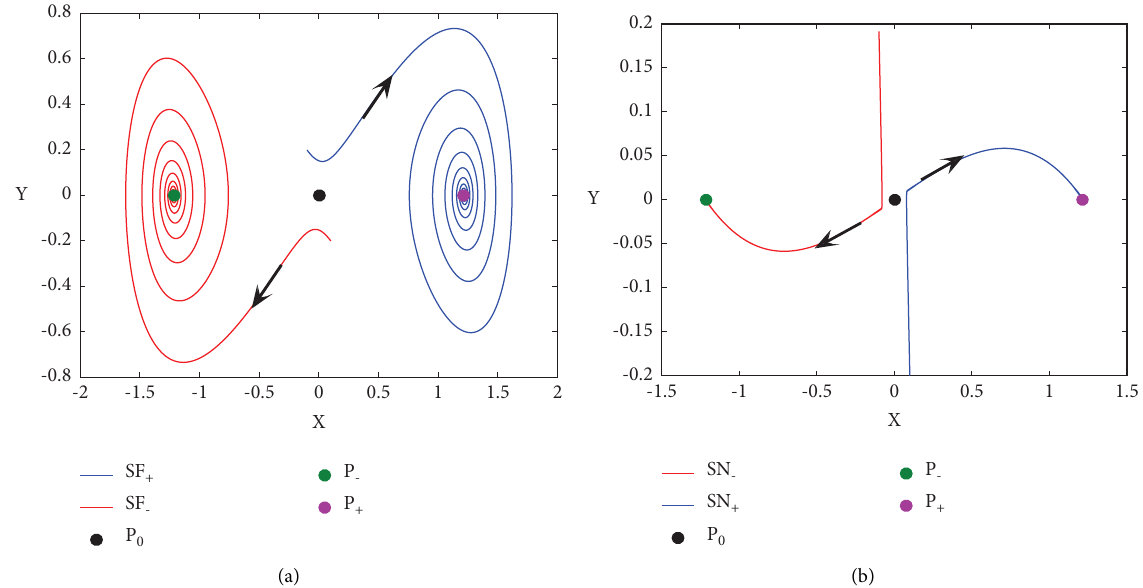
Figure 10: Bistability of equilibrium attractors in the plant-wind system. In each curve, there are two stable focuses separated by a saddle obtained for c � 0 with (a) ξ � 0 . 5 and (b) ξ � 2 .